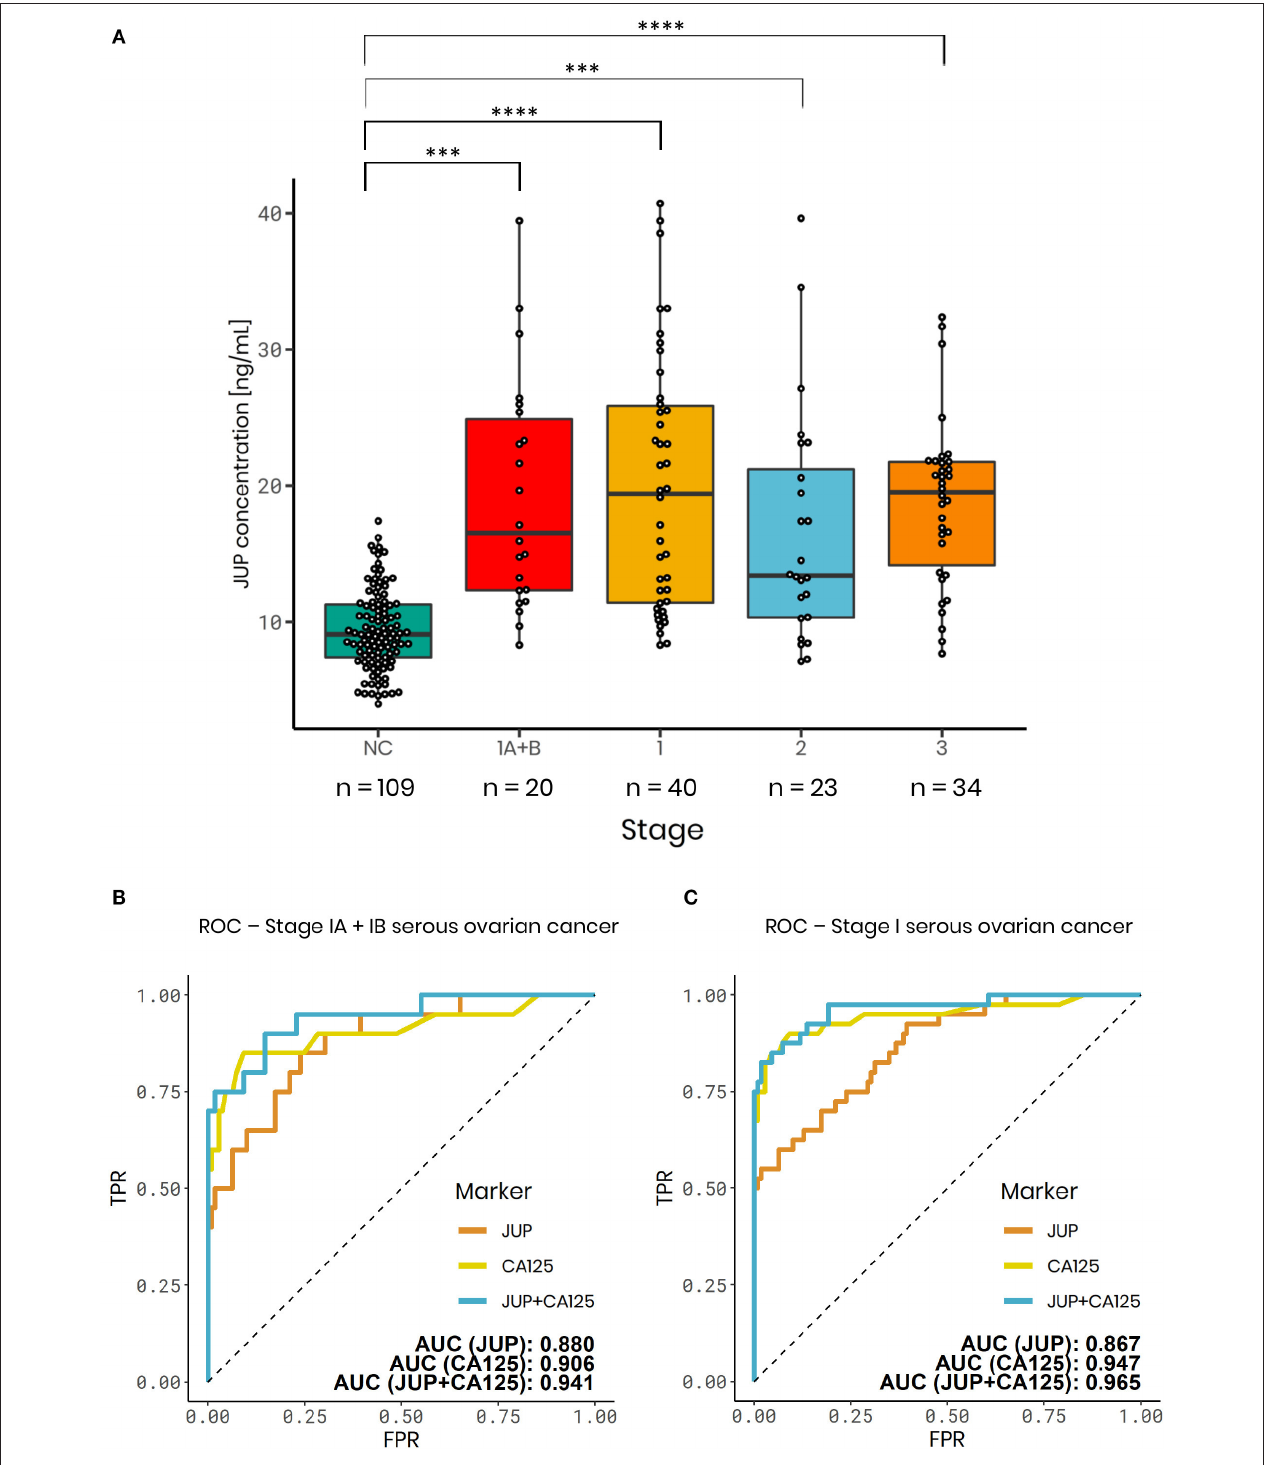
FIGURE 3 | JUP plasma ELISA results for the international, multicenter serous ovarian cancer validation cohort. (A) Boxplots of normal controls (NC) (median = 9.09ng/mL), serous ovarian carcinomas - Stage IA + B (median = 15.45ng/mL), stage I (median = 18.13ng/mL), stage II (median = 13.49ng/mL), and stage III (median = 19.52ng/mL). Serous carcinomas vs. NC ( n = 109) - Stage IA + B (1.97-fold change; p < 0.001; n = 20); stage I (2.09-fold change; p < 0.0001; n = 40); stage II (1.81-fold change; p < 0.001; n = 23) and stage III (1.98-fold change; p < 0.0001; n = 34). (B,C) ROC analysis of JUP (orange), CA125 (yellow) and a logistic regression model combining JUP + CA125 (blue). AUC values: (B) Serous carcinomas - Stage IA + B: JUP: 0.880; CA125: 0.906; JUP + CA125: 0.941. (C) Serous carcinomas - Stage I: JUP: 0.867; CA125: 0.947; JUP + CA125: 0.965. *** p -value < 0.001, **** p -value < 0.0001.